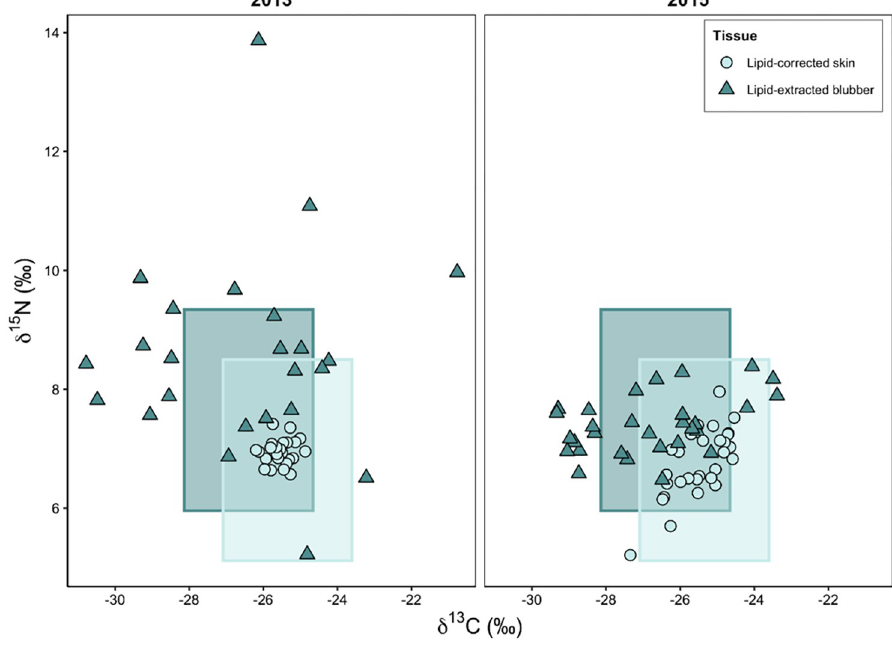
Fig 4. Scatterplot illustrating the tissue-specific krill space for δ 13 C and δ 15 N values of lipid-adjusted blubber and skin tissue of 2013 (n = 24) and 2015 (n = 30).